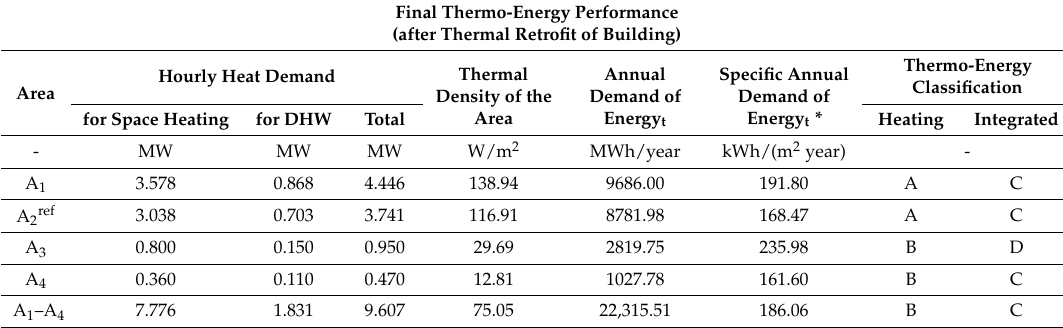
Table 5. Work Scenario no. 2,